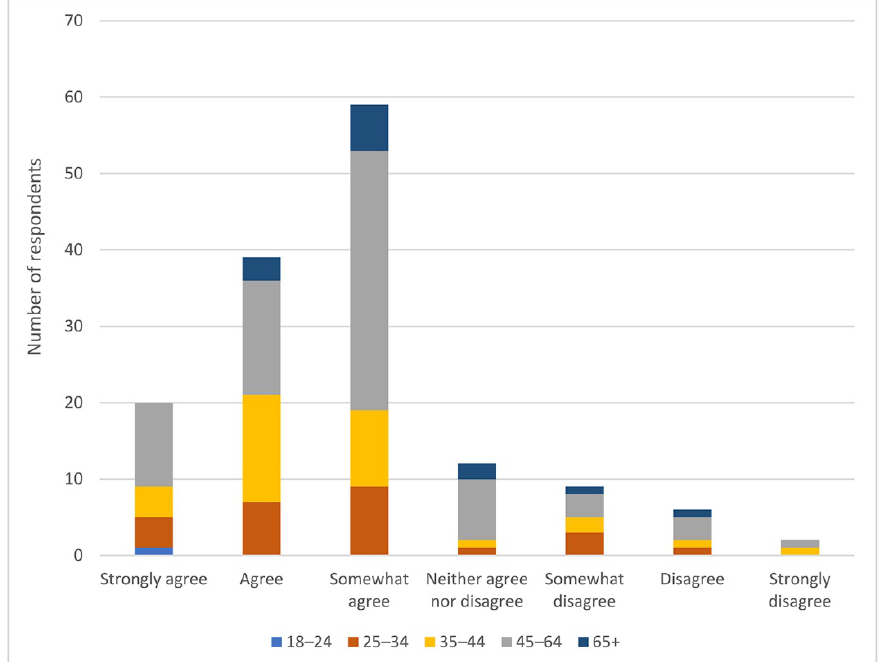
Figure 4 Respondents’ belief that age and/or generation has an impact on communication in the workplace based on respondent